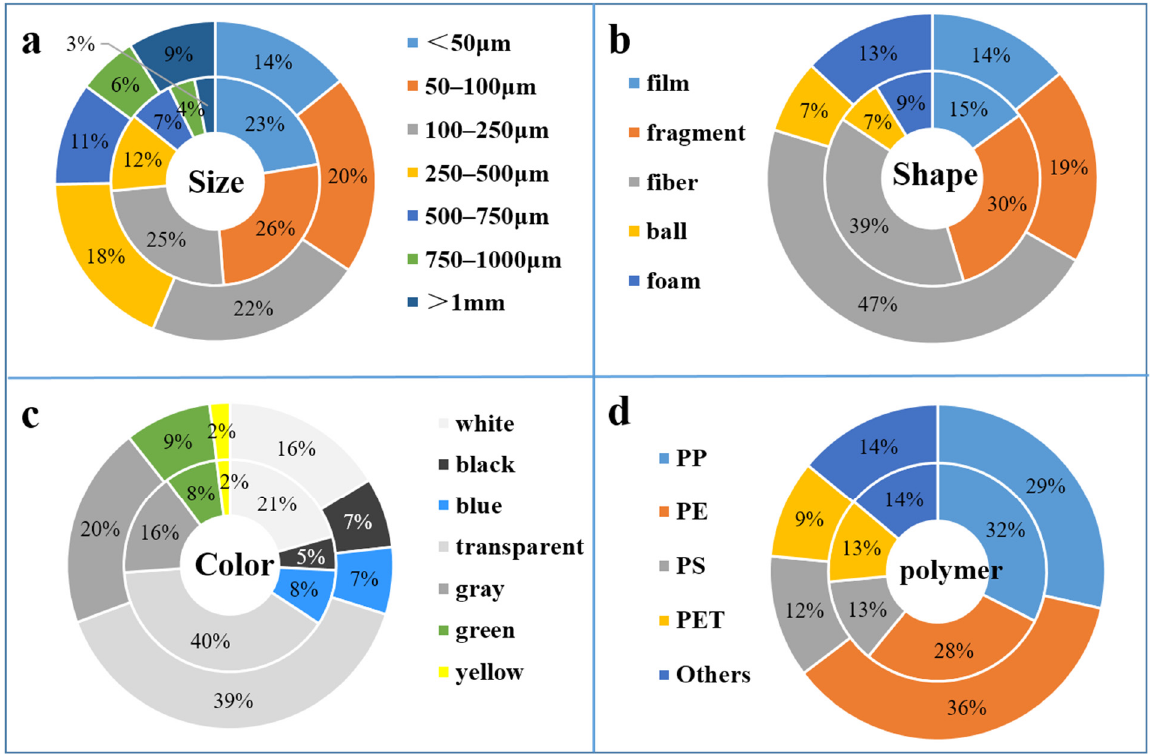
Figure 4. Size ( a ), shape ( b ), color ( c ) and polymer ( d ) distribution of MPs in samples (outer ring = water, inner ring = sediment).